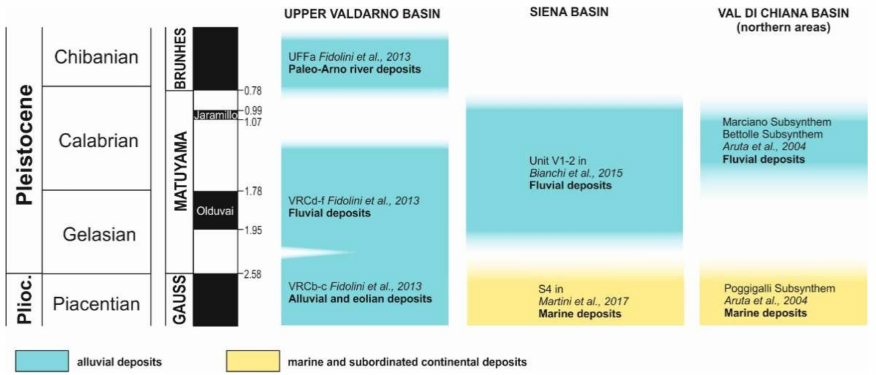
Figure 4. Age of deposits filling the Upper Valdarno, Siena and Val di Chiana Basins during Plio- Pleistocene